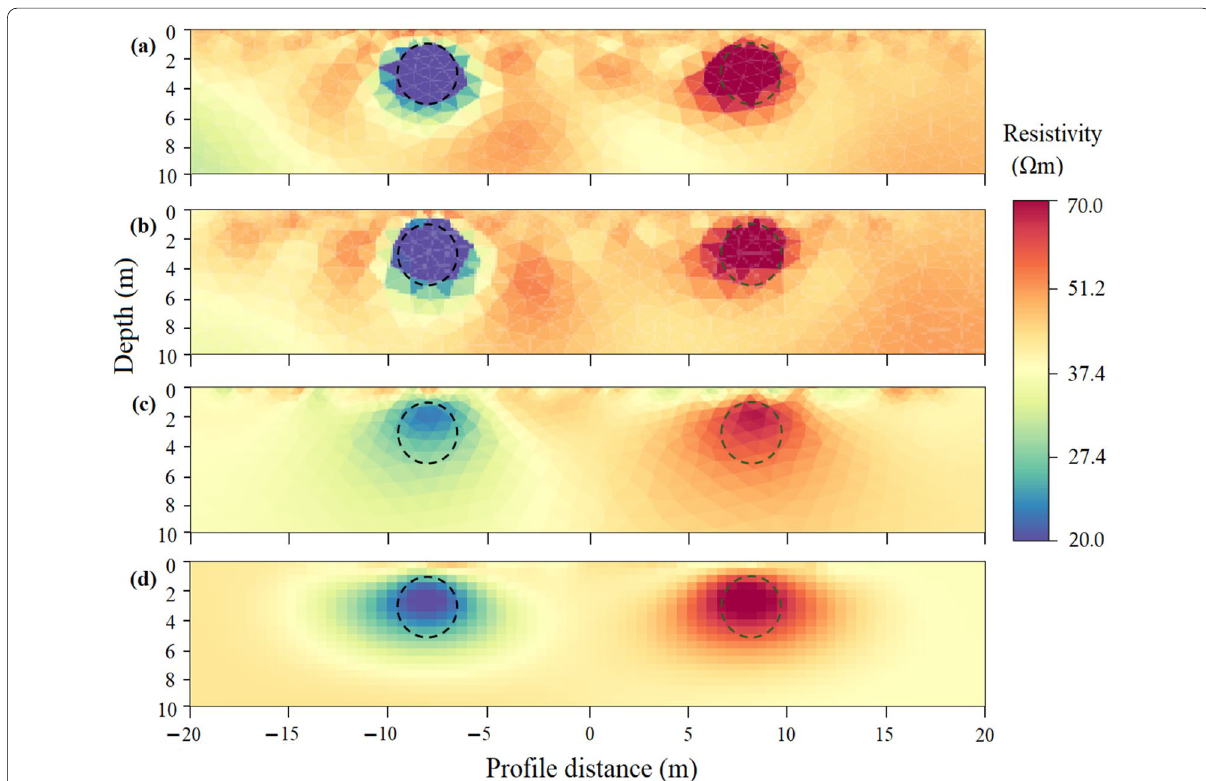
Fig. 12 The recovered model of scenario four for a 2 m target radius located at 3 m depth applying the inversion freeware: a pyGIMLi, b BERT, c ResIPy, and d SimPEG. The broken circles show the actual targets; the left for conductive while the right for resistive target. pyGIMLi, BERT, and ResIPy use unstructured triangular mesh, while SimPEG implements tensor mesh